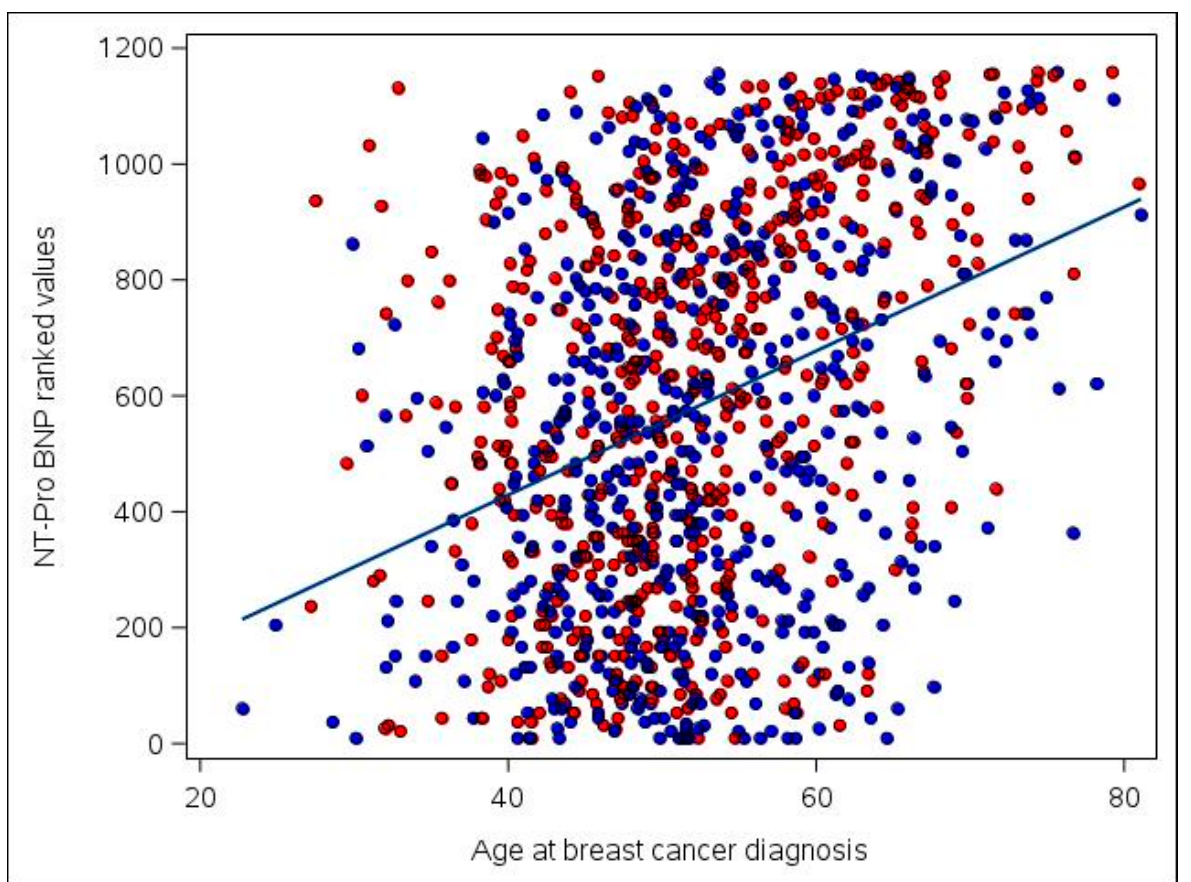
Figure 1. Association of ranked NT-proBNP values with age at breast cancer diagnosis among the 1160 participants included in the study. Ranked NT-proBNP values range from 1 (for the participant with the lowest original/raw NT- proBNP value) to 1160 (for the participant with the highest original/raw value). Anthracycline users are plotted in red and non-anthracycline users are plotted in blue. A least squares regression line is superimposed on the figure for ease of interpretation. Correlation = 0.36 ( p < 0.001).